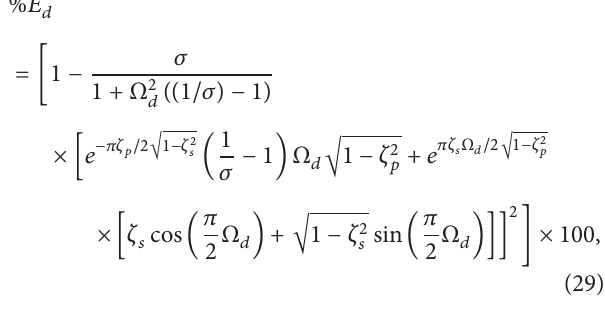
Figure 10: (a) Displacement response for both the main (—) and the secondary system ( - - - ). (b) Energy levels in the system. Time is normalised with respect to the mean period 𝑇 𝑚 . For this example the stiffness reduction ratio is 𝜎 = 0.75 and the mass ratio 𝜇 = 0.25 , giving a secondary to primary system frequency ratio Ω = 3 and maximum energy dissipation (— total energy; - - - kinetic energy; ⋅⋅⋅ potential energy).